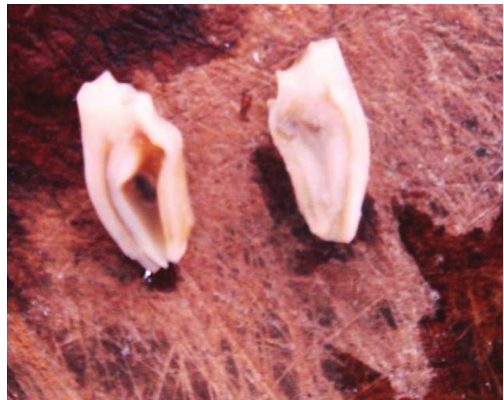
Figure 3: Longitudinal section of involved tooth showing invagina- tion in root of mandibular right first